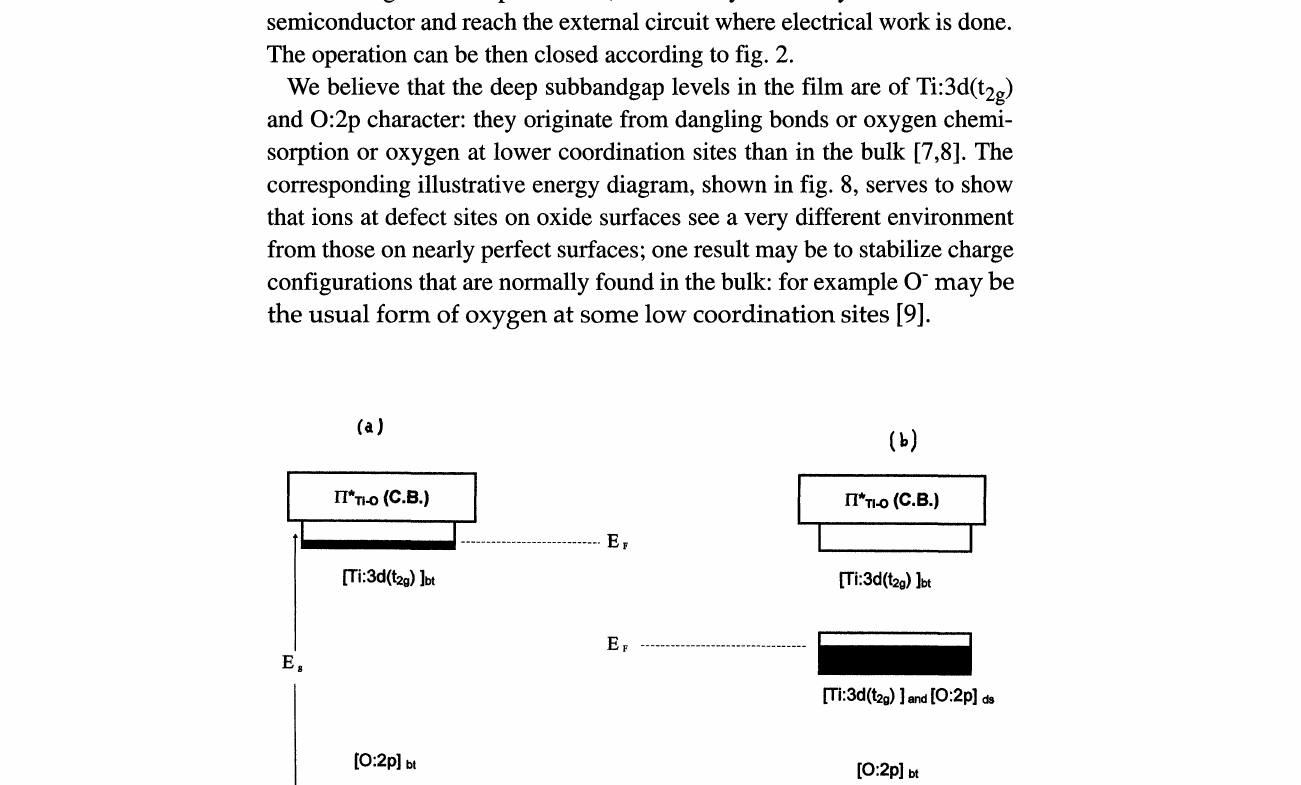
FIGURE 8 Simplified band-energy scheme of nanocrystalline n-SrTiO films. (a) nearly perfect crystallite surface, (b) actual crystallite surface. The titanium and oxygen bt (band-tailing) ([Ti:3d(t2g)]l and (0:2p]lt) energy states originate from Ti-O bond weakening, or decrease of the Madelung potential, at surface sites. The [Ti:3d(t2g)]dst and [0:2P]dsl energy states represent the deep subbandgap energy states (dsb), which origi- nate from dangling bonds or oxygen chemisorption, or oxygen at lower coordination sites than in the bulk